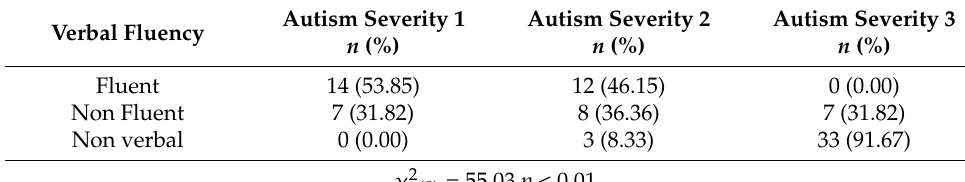
Table 4. Association between verbal fluency and autism